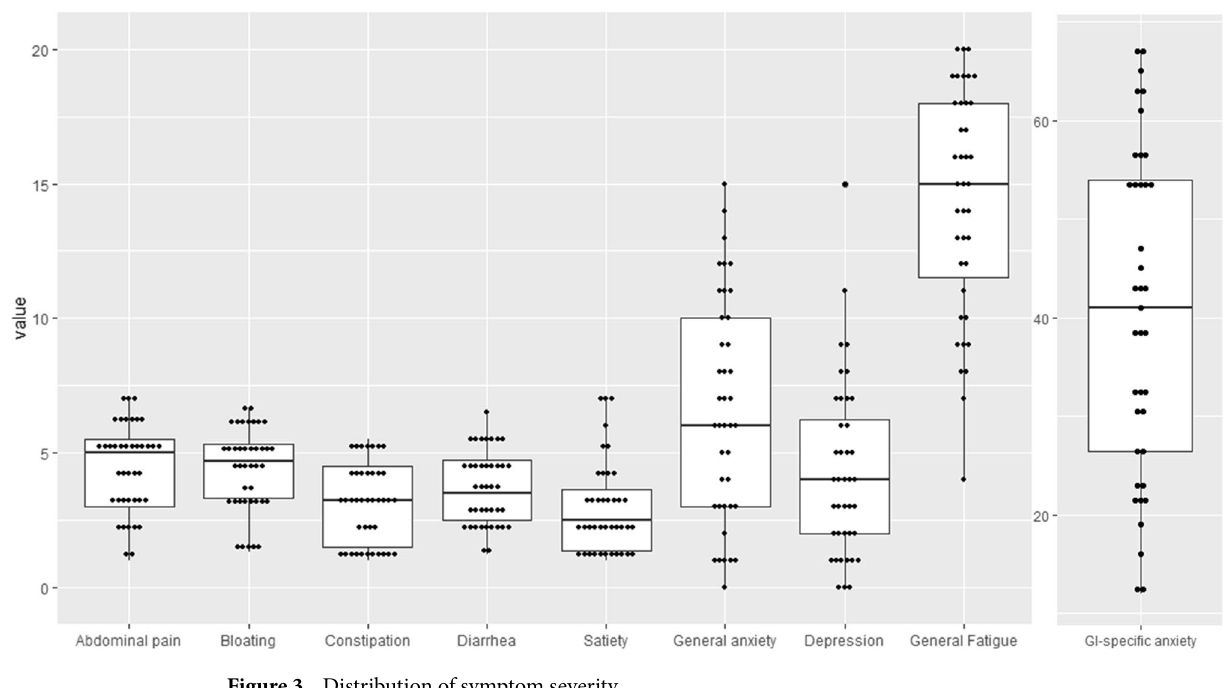
Figure 3. Distribution of symptom